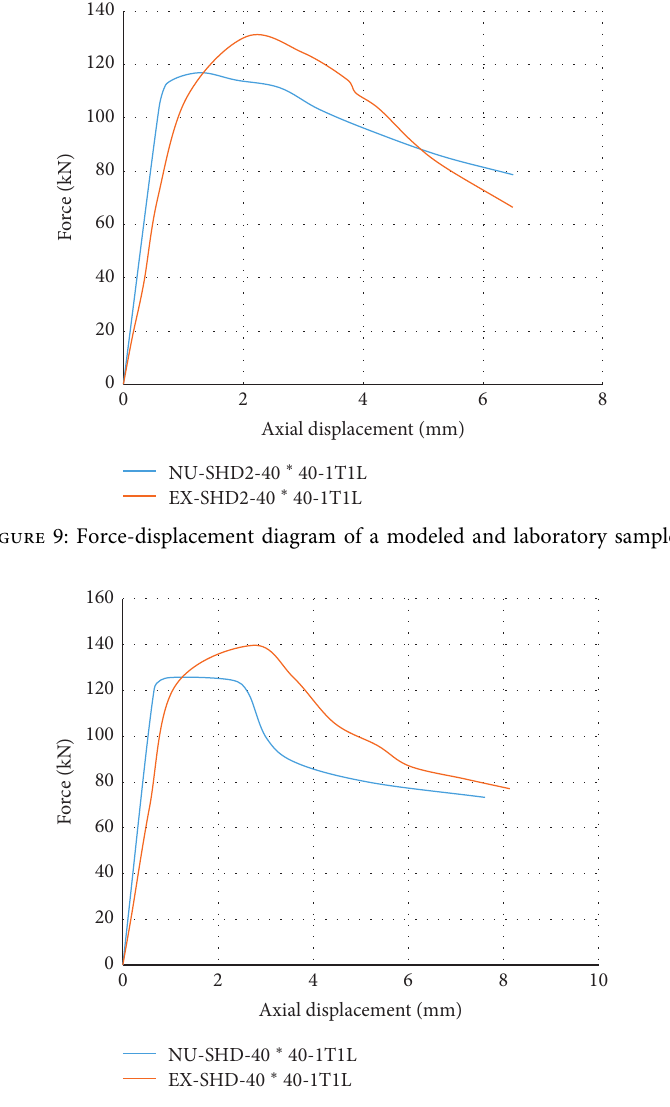
Figure 10: Force-displacement diagram of model and laboratory